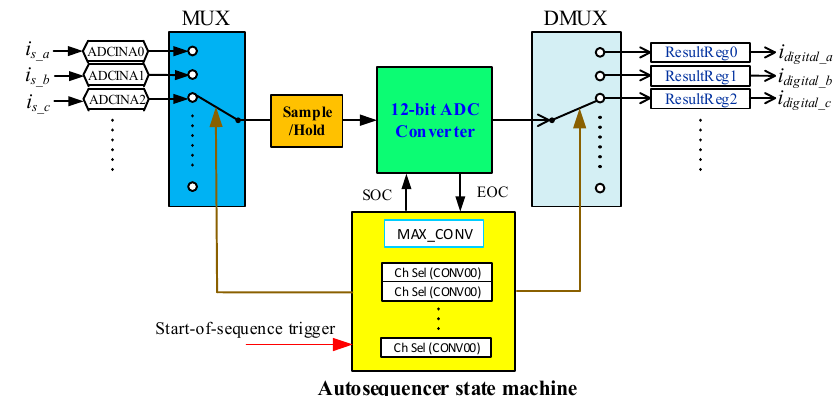
Figure 7. Hardware structure of the data acquisition system.